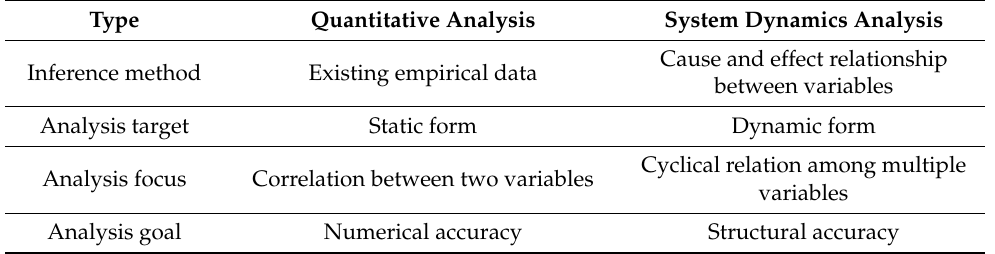
Table 3. Comparison of prediction simulation types and